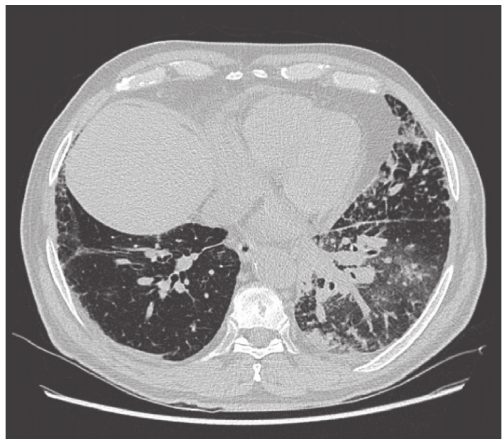
Figure 1: Computed tomography of chest showing transverse view of lungs with multiple patchy ground glass opacities with pre- dominant lower lobe involvement, more than a month after initial presentation.